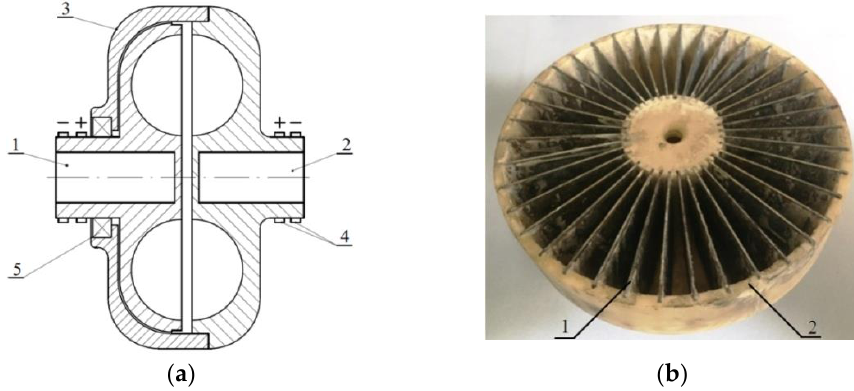
Figure 2. HB geometry for calculations (refer to Table 1). Table 1. PHB data.